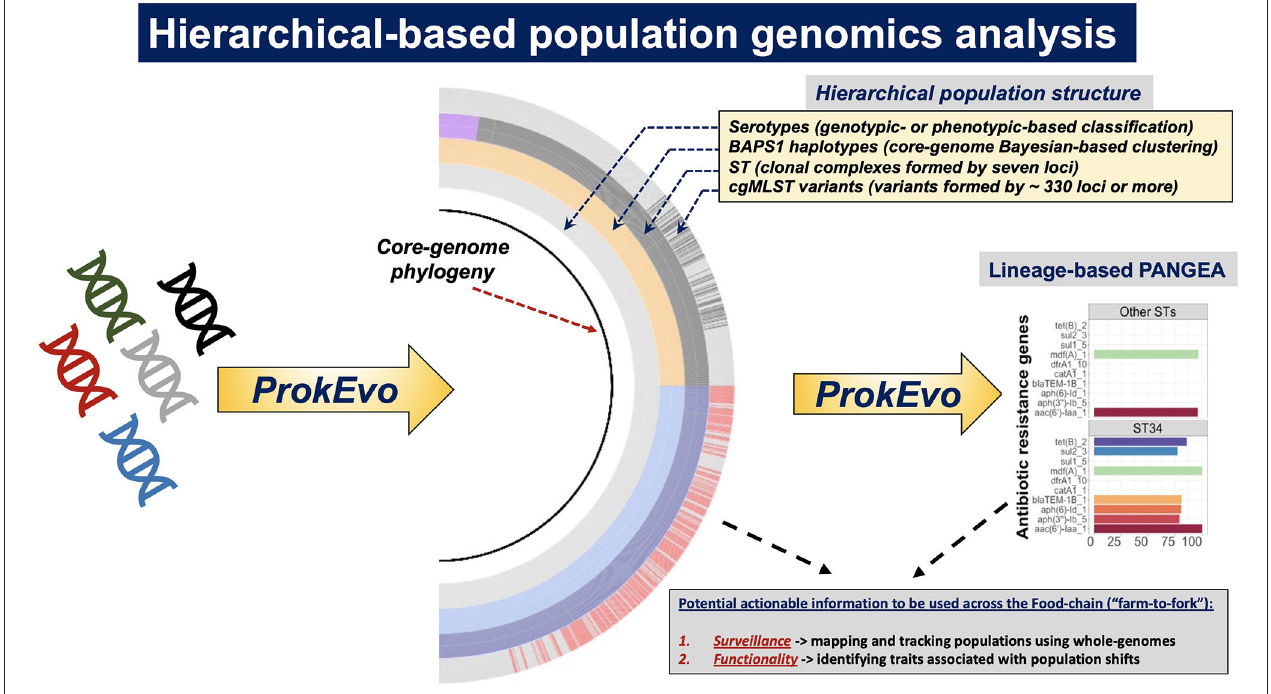
FIGURE 1 | Systems-deployable heuristic and hierarchical-based population genomics analysis of Salmonella whole-genome sequences for discovery of novel actionable food-safety related information. Illumina raw paired-end genomic sequences were processed through the computational pipeline ProkEvo in order to generate two main outcomes: (1) A hierarchical-based population analysis of genotypes, at different levels of resolution, used to reveal unique lineages/variants and their genetic structure and relationships; and (2) Loci and plasmid mapping using pan-genomic information to predict traits of interest. For S. enterica lineage I, we used a top-down hierarchical-based system of classification comprised of serovars at the lowest level, followed by BAPS1 sub-groups or haplotypes, ST, and cgMLST at the highest level of resolution. Unique loci differentiating between lineages were found using our PANGEA approach, and by agnostic and statistically-based pattern searching across pan-genomic data, in addition to outputs from databases such as Resfinder. Lineage-associated plasmids were found by data mining results from genomic mapping using plasmid-related database. Ultimately, genotypic classifications and predicted traits were combined to obtain two levels of potentially actionable information, including (i) surveillance cues for mapping and tracking canonical and cryptic populations; and (ii) phenotypic inference of traits related to food safety that may in turn result in practical applications across the food